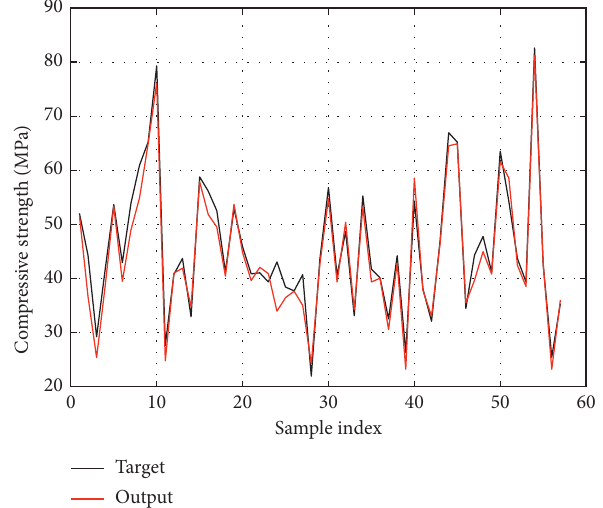
Figure 6: Prediction results of FNN for the testing dataset.